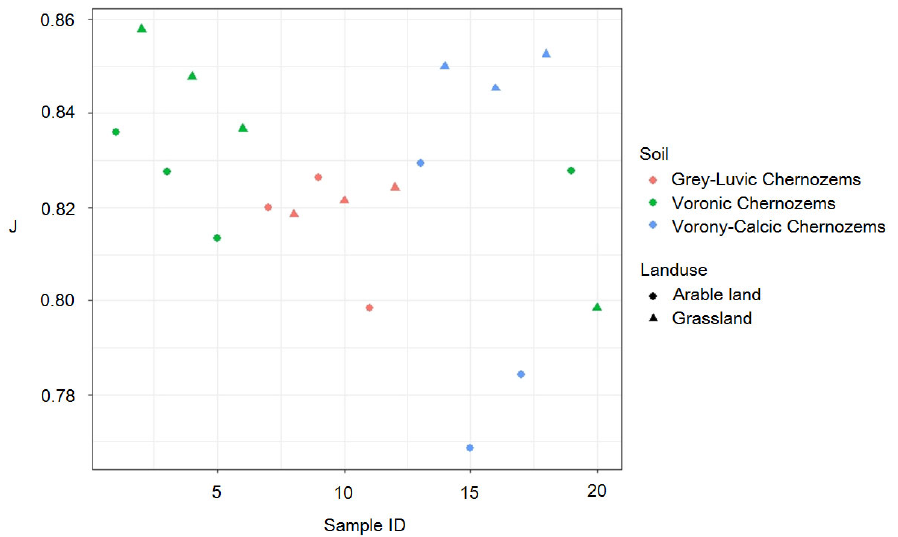
Figure 3. Pielou evenness indexes scatter plot. Index values are deferred on the vertical axis. Nonarable sites marked as grassland. Odd sample IDs and even ones to the right of them correspond to paired samples.